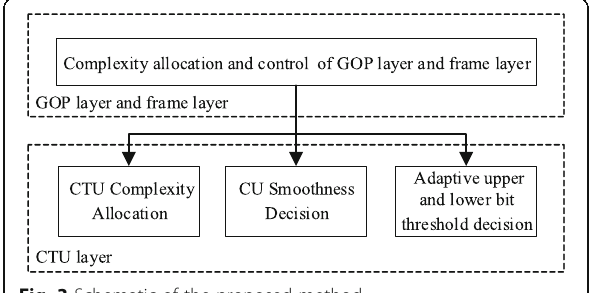
Fig. 3 Schematic of the proposed